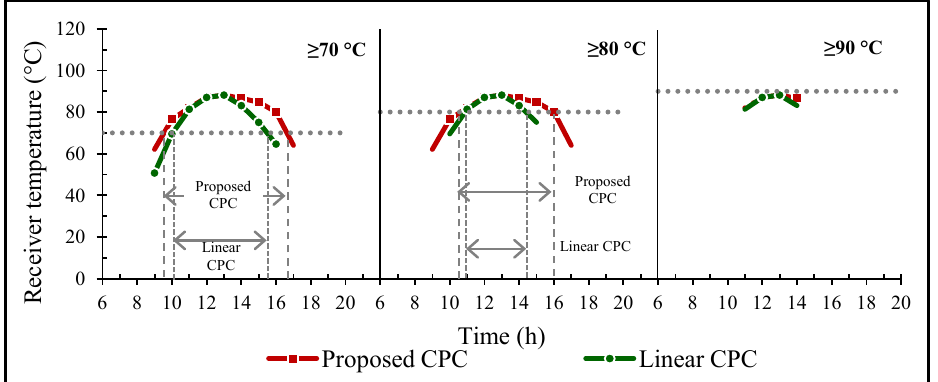
Figure 10. Duration of the selected temperatures per unit length of the proposed angled CPC and linear south-facing CPC (11 November